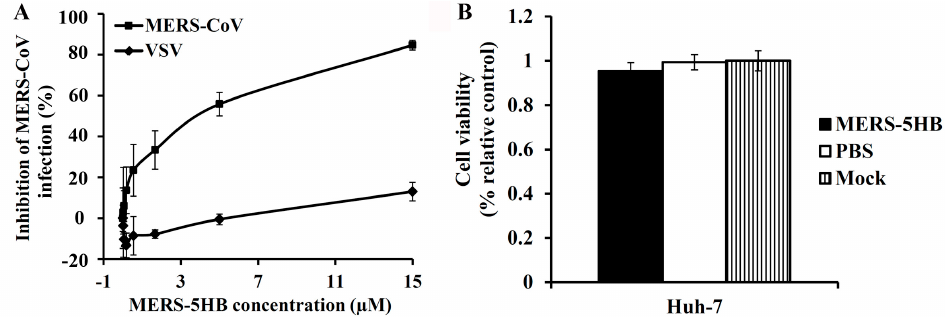
Figure 3. Inhibition of MERS-CoV viral entry by MERS-5HB. ( A ) Inhibitory activity of MERS-5HB on MERS-CoV pseudovirus entry. MERS-5HB was tested for inhibition of a single-cycle infection on Huh-7 cells by pseudotyped MERS-CoV using vesicular stomatitis virus (VSV) as control. The inhibitory effect was described as % inhibition. ( B ) The cytotoxicity of MERS-5HB to Huh-7 cells. PBS was the control and Mock represents normal culture of Huh-7 cells. Experiments were performed in quadruplicate, and the data were presented as mean ± s.d. (error bar). The tests were repeated twice and similar results were obtained.